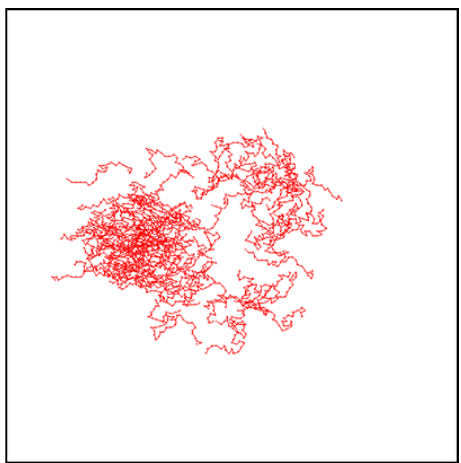
Figure 12. Instantaneous configurations of chains in FPM after 6000 MCS. ∇ I = 0.005, I 0 = 0.5 and Θ = 0 ◦ . One hundred chains are shown.